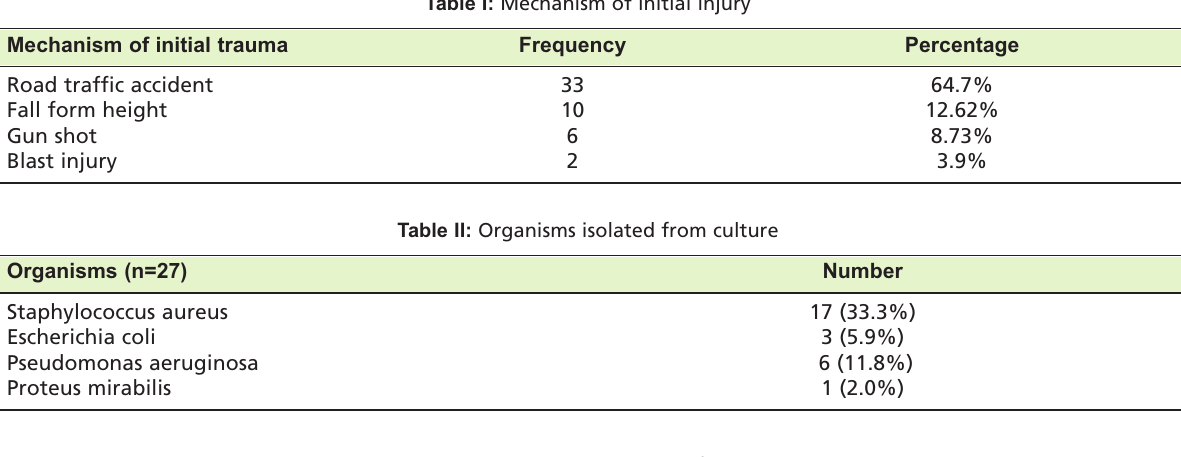
Complications observed after ilizarov Table III: